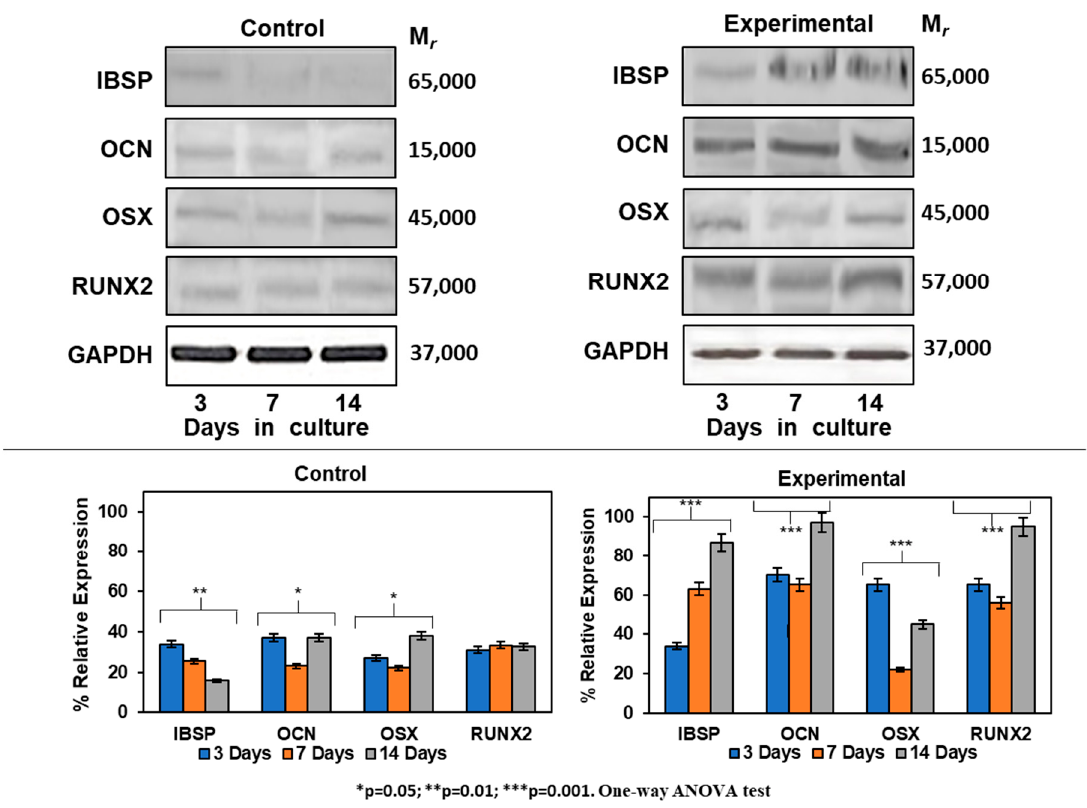
Figure 7. Expression of mineralization-related markers at the protein level. Experimental cultures treated with 4 µg/mL showed a higher expression of IBSP, OSX, RUNX2 and OCN at all terms tested.